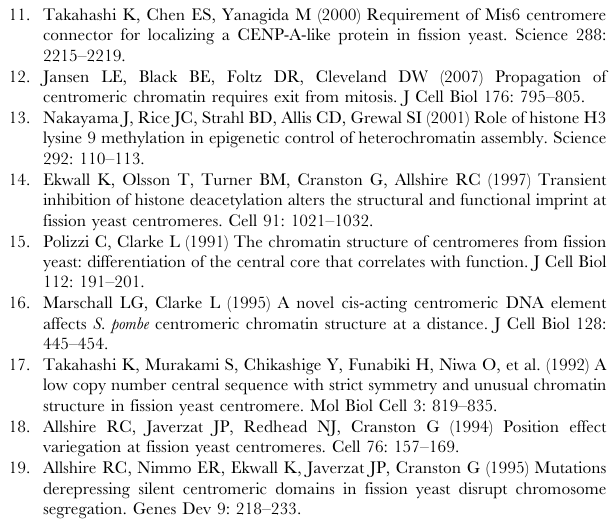
is shown. Open bars and shaded bars indicate results of 25 u C and